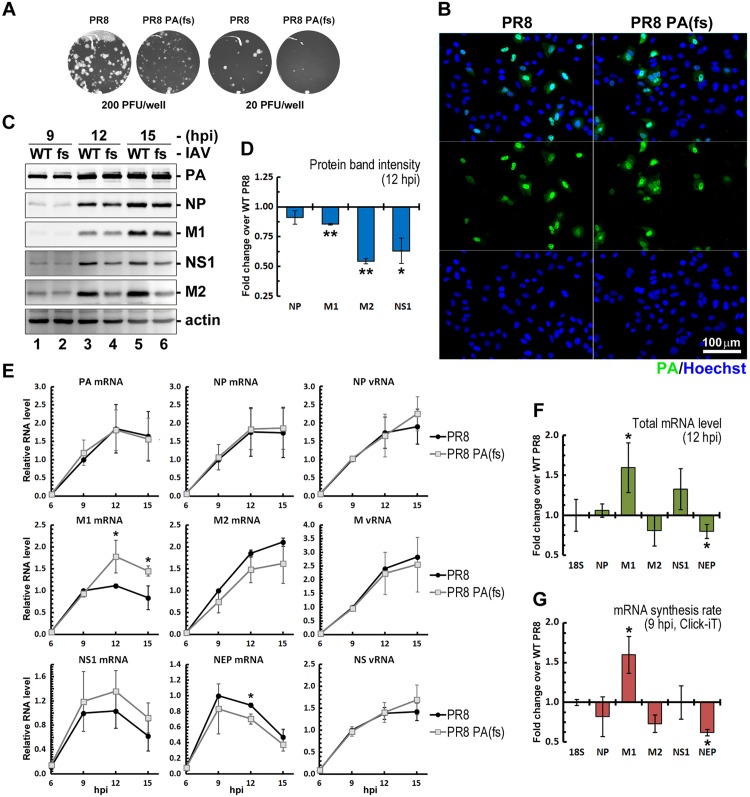
PA-X activity facilitates viral protein synthesis.(A) Crystal violet staining of plaques generated by wild-type PR8 and the PR8-PA(fs) mutant viruses in Vero cells, showing a decrease in plaque size for PA-X-deficient mutant compared to wild-type virus plaques. (B-D) A549 cells were infected with PR8 or PR8-PA(fs) IAV at a MOI of 0.25. (B) At 12 hpi cells were fixed and the infected cells were identified by immunofluorescence staining for IAV PA protein (green) to confirm that infection rates were highly similar between the two virus inoculums. Cell nuclei were stained with Hoechst dye (blue). (C) Viral protein accumulation was determined by western blotting of the whole cell lysates collected at the indicated time points. (D) Band intensities from (C) were quantified using ImageJ software (NIH) from two independent experiments. Error bars = st. dev. (E) Total RNA was isolated from cells infected as in (A-C) and the mRNA and vRNA levels for a subset of IAV genes were measured by RT-qPCR. Data was normalized to 18S rRNA and values plotted relative to 9 hpi levels in wild-type virus infected cells. (F) The levels of the indicated viral mRNAs at 12 hpi from (E) were plotted as fold change in PR8-PA(fs) infected cells vs. PR8 wild-type infected cells. (G) Rates of RNA synthesis were determined for the indicated genes at 9 hpi using Click-iT nascent RNA labeling and plotted as fold change in PR8-PA(fs) infected cells vs. PR8 wild-type infected cells. 18S values were normalized to input RNA concentration, whereas viral mRNA values were normalized to 18S levels. Error bars = st.dev. from three independent biological replicates. *,** = p value < 0.05, 0.01 for PR8-PA(fs)- vs. PR8-infected cells.